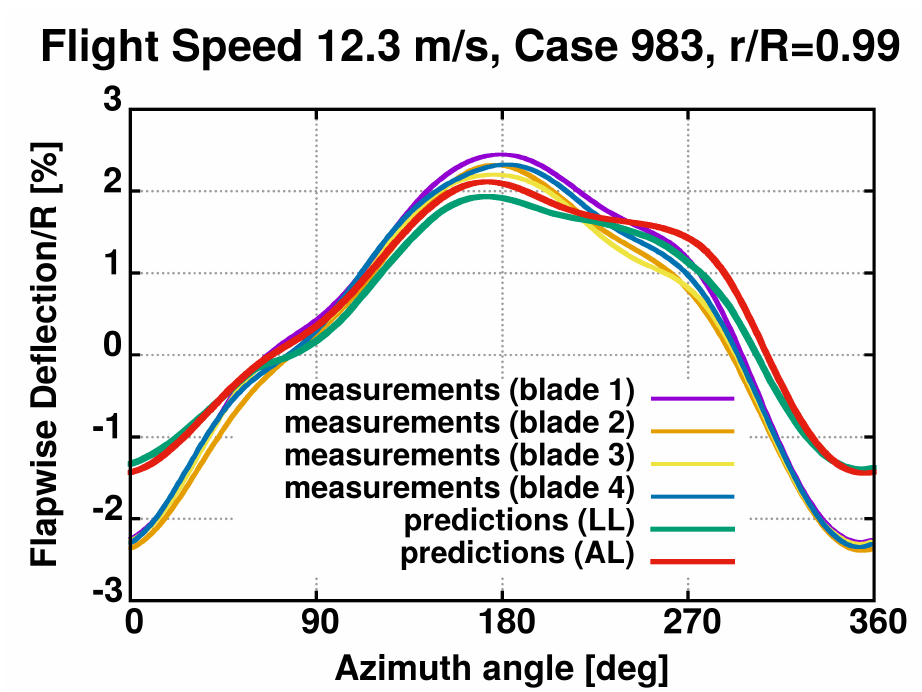
Figure 39. Forward flight at 12.3 m/s, case 983. Flapwise deflection at r / R =